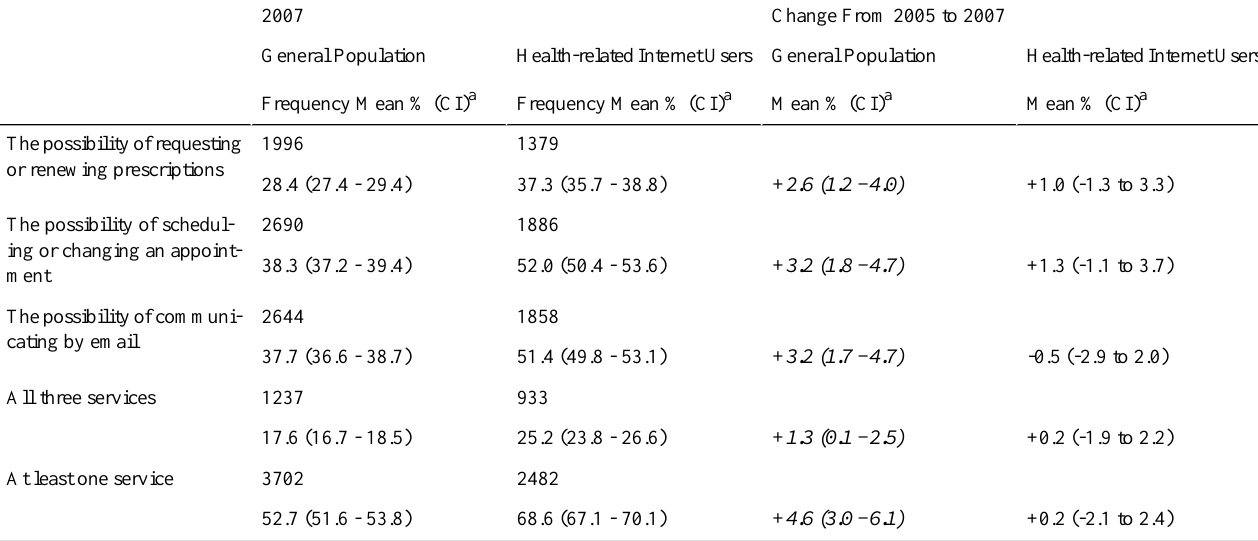
Table 3. Importance of eHealth services when choosing a new doctor in 2007 and changes from 2005 to